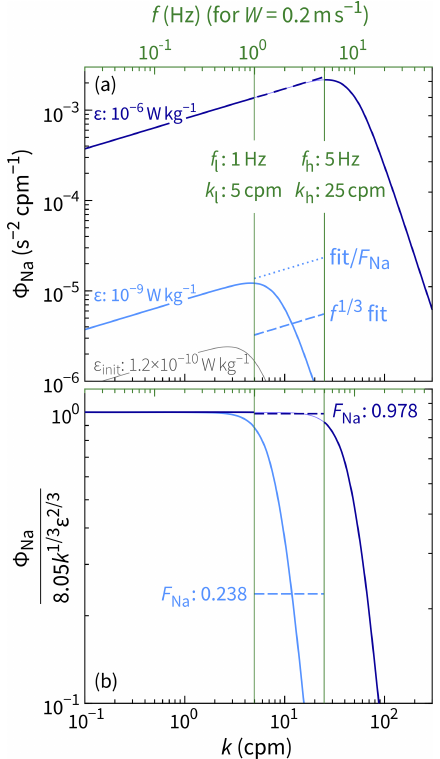
Figure 1. Calculation of the correction function F Na for two val- ues of (cid:15) . For (cid:15) = 1 × 10 − 6 Wkg − 1 , a k + 1 / 3 power law is a good approximation of the Nasmyth spectrum over the frequency range f l – f h (1–5Hz) for a profiling speed of W = 0 . 2ms − 1 . Although the same is not true for (cid:15) = 1 × 10 − 9 Wkg − 1 , we can account